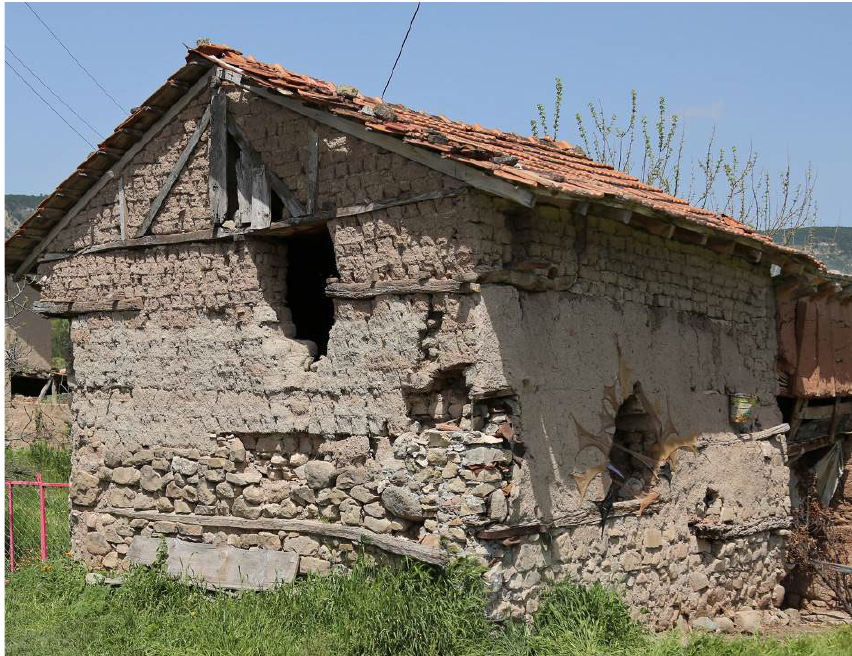
Figure 20 Cementitious repair on the masonry wall and rendering (Keep Your Village Alive